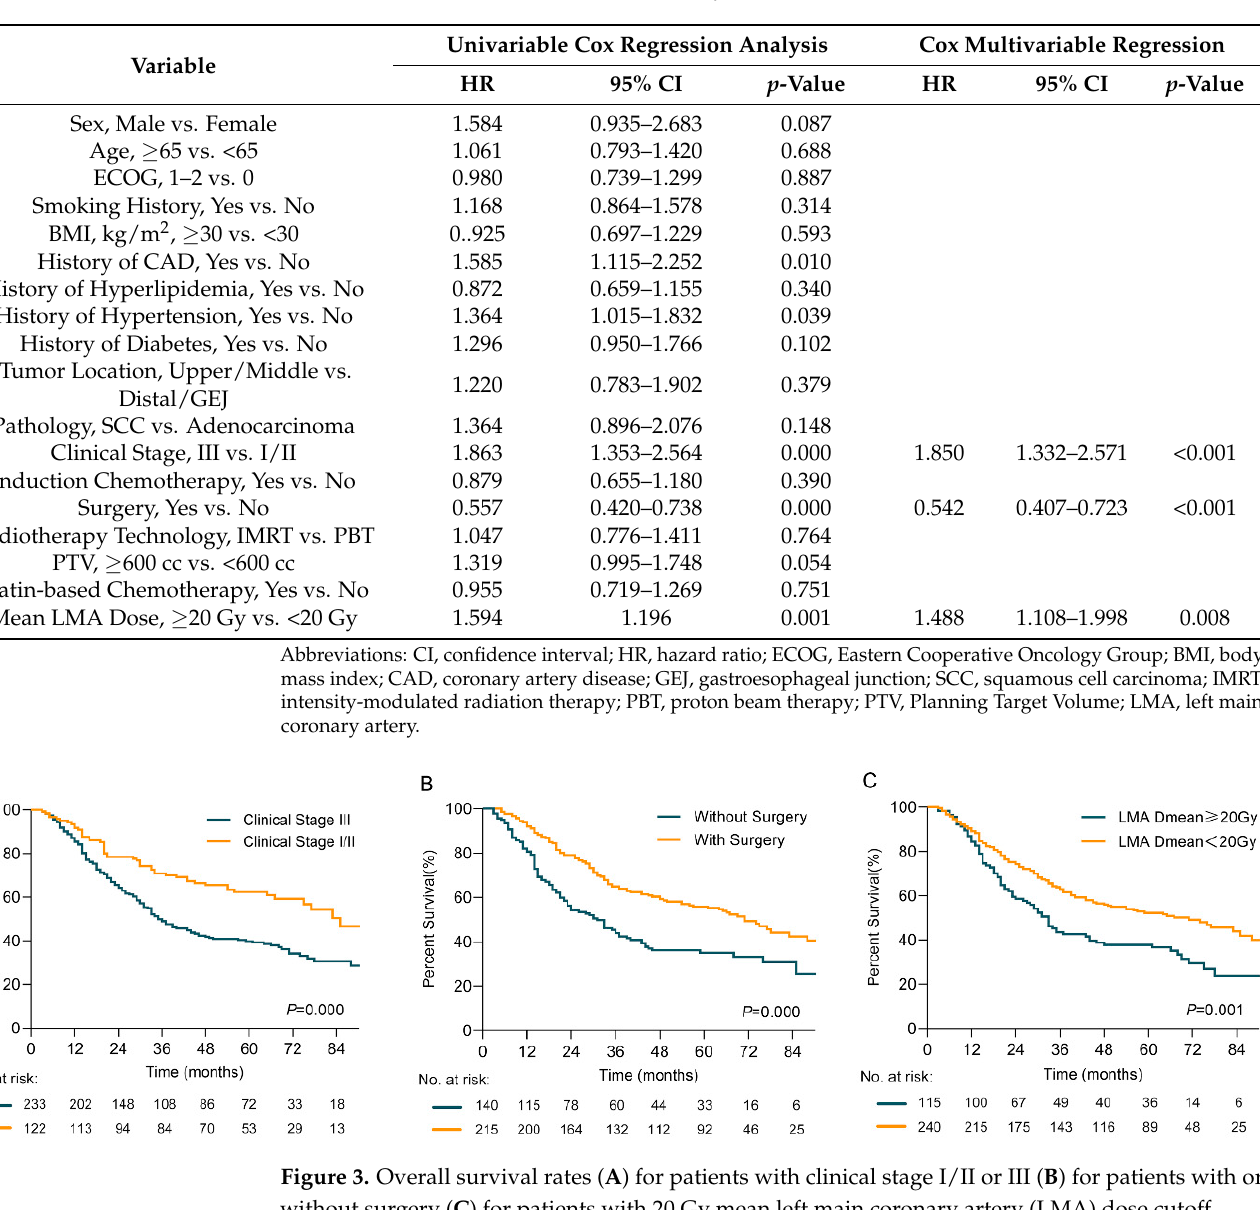
Table 3. Univariable and multivariable analysis for overall survival.